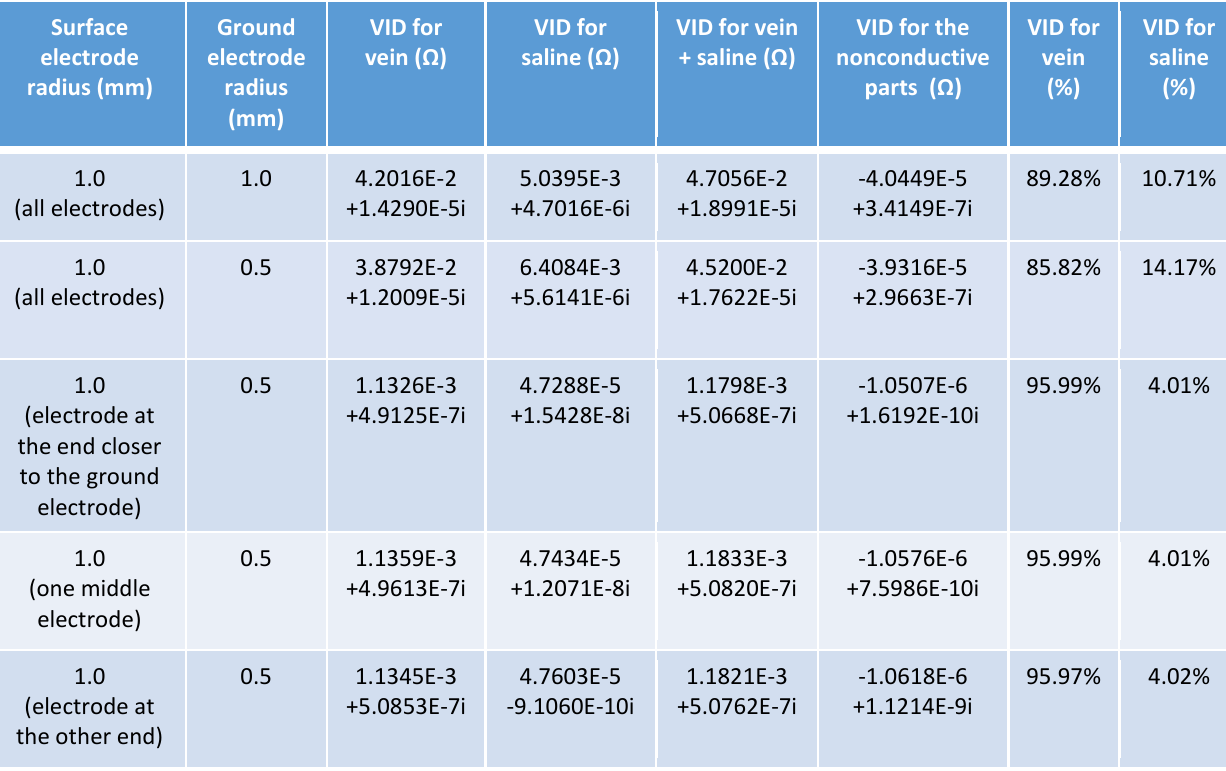
Table.15: Volume integration of Volume Impedance Density (VID) measurements at 1MHz with both all and one of the 44 surface electrodes as terminal (11 electrodes in 4 rows)